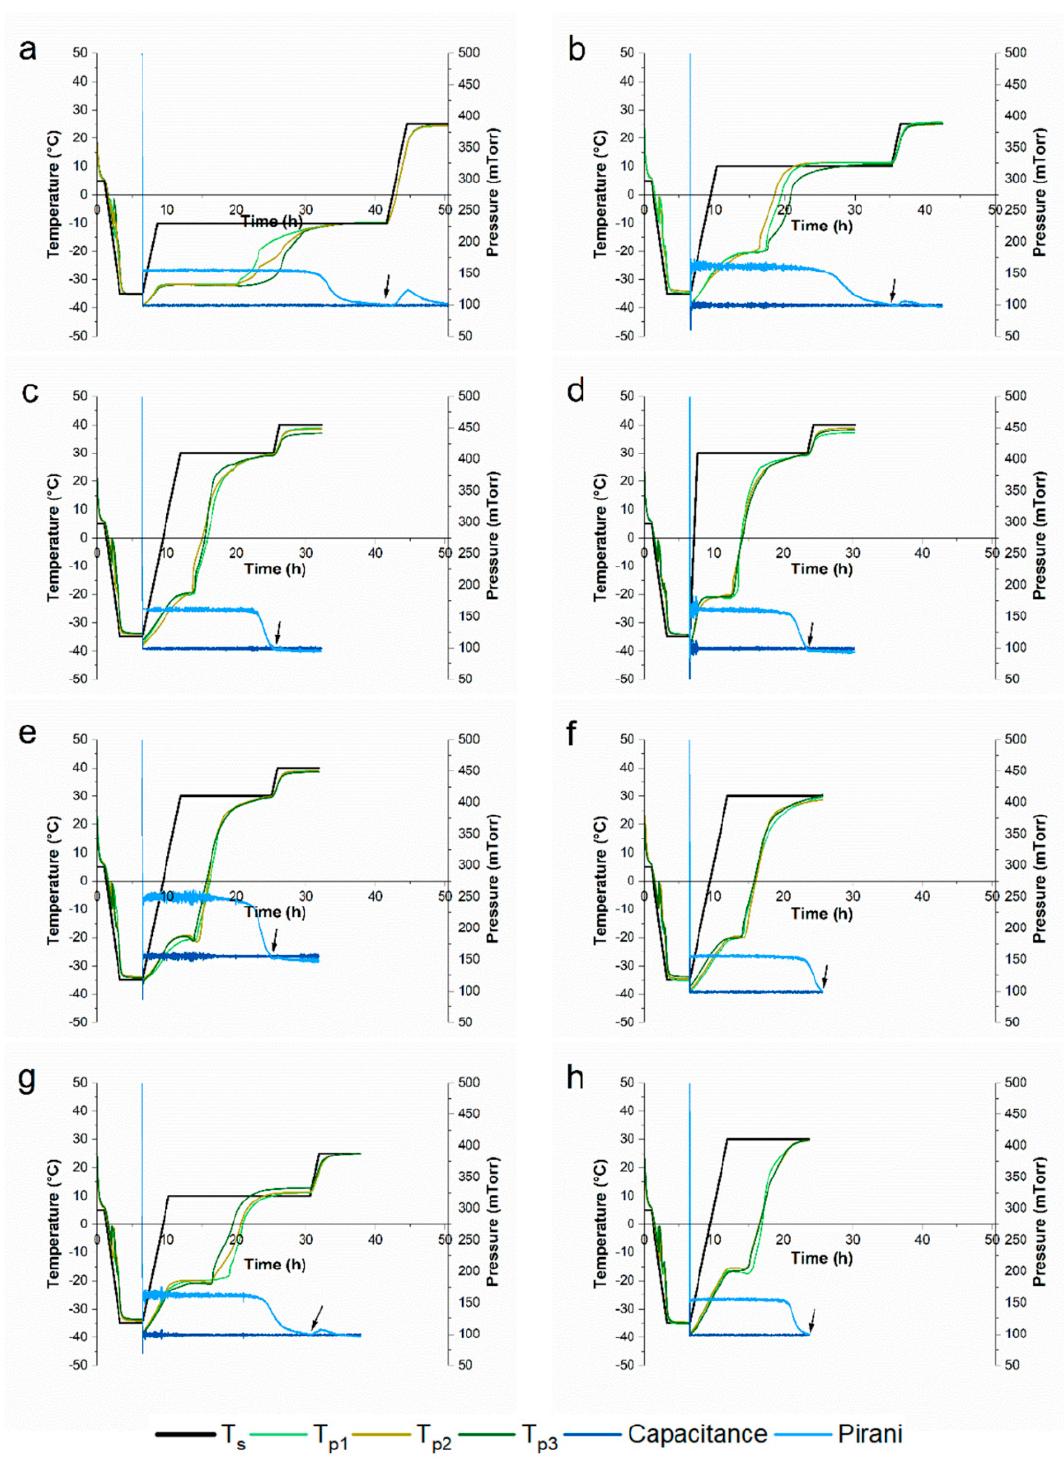
Figure 1. Freeze-drying cycles. Process monitoring data of ( a – f ) 10 mg / mL mAb formulations and of ( g – h ) 50 mg / mL monoclonal antibody (mAb) formulations. ( a ) The conservative cycle (C0), ( b , g ) C1, ( c ) C2, ( d ) C3, ( e ) C4, and ( f , h ) C5. The arrow indicates end of primary drying. T s = shelf temperature; T p = product temperature determined by thermocouples.